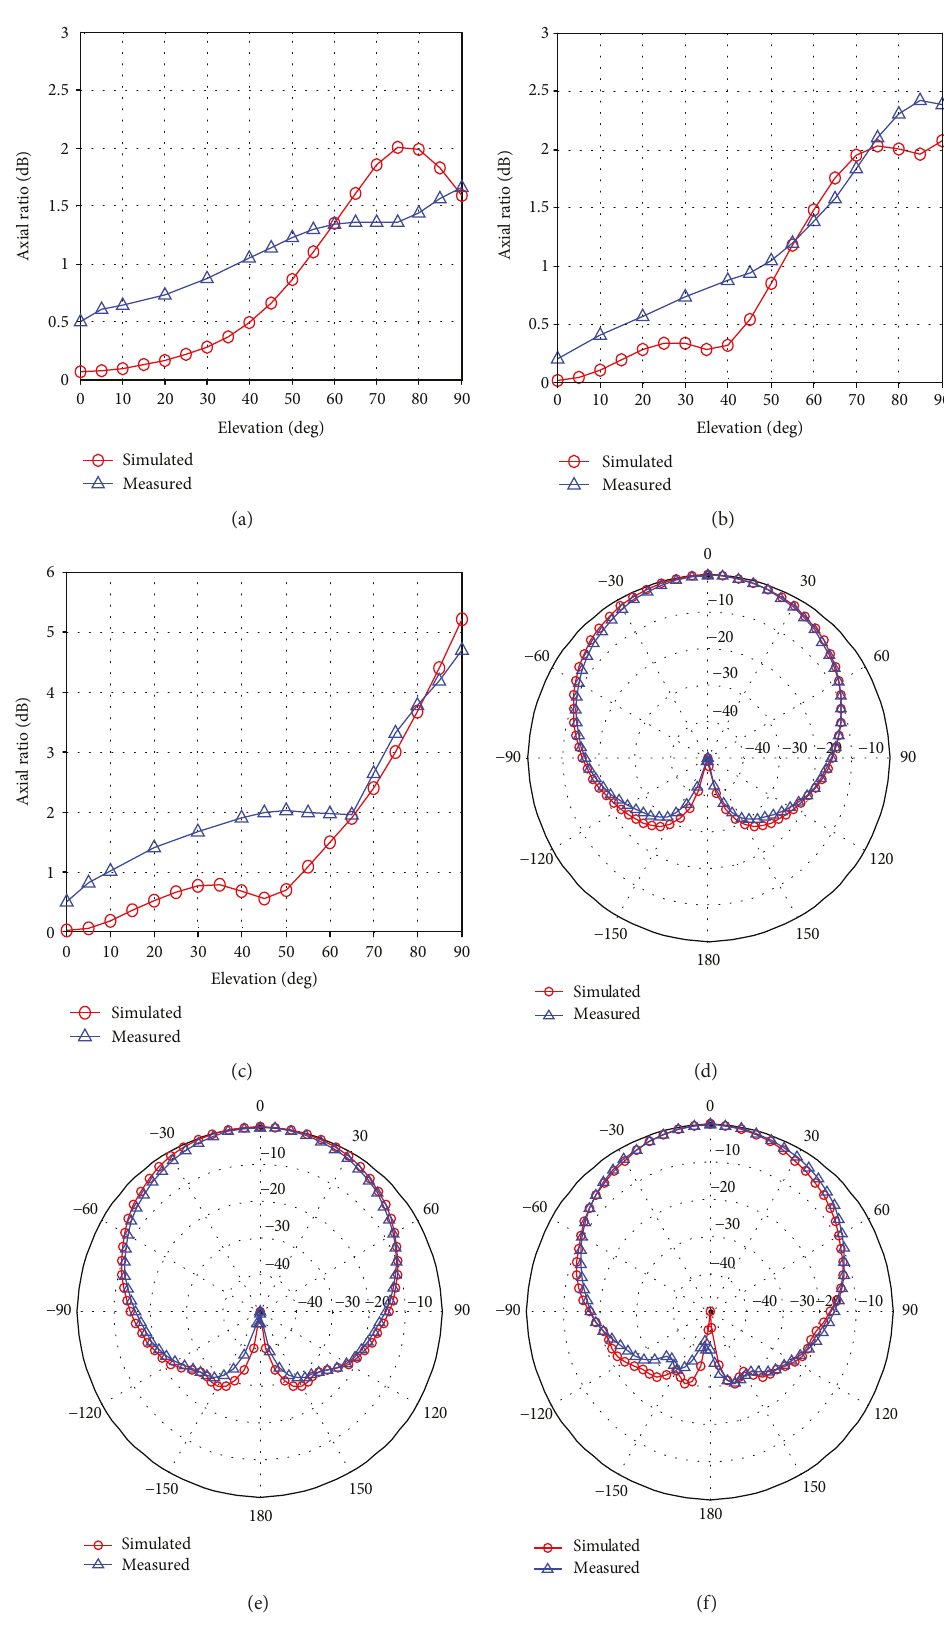
Figure 8: Comparison of simulated and measured radome: maximum axial ratio versus the elevation angle (a) at 1.22GHz, (b) at 1.58GHz, and (c) at 2.5GHz; E-plane radiation pattern (co-pol) (d) at 1.22GHz, (e) at 1.58GHz, and (f) at